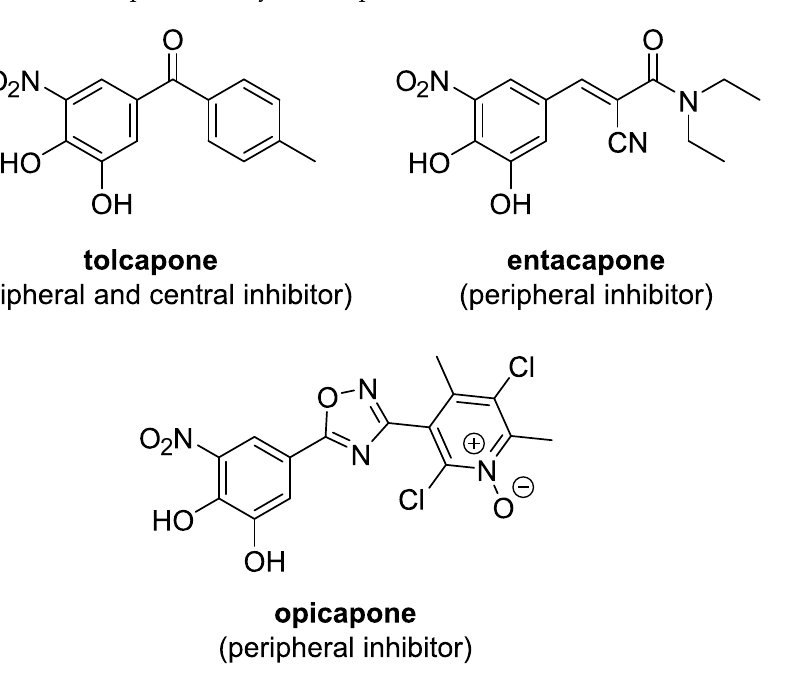
Figure 1 . Examples of COMT inhibitors based on the nitrocatechols moiety [12–15]. Figure 1. Examples of COMT inhibitors based on the nitrocatechols moiety